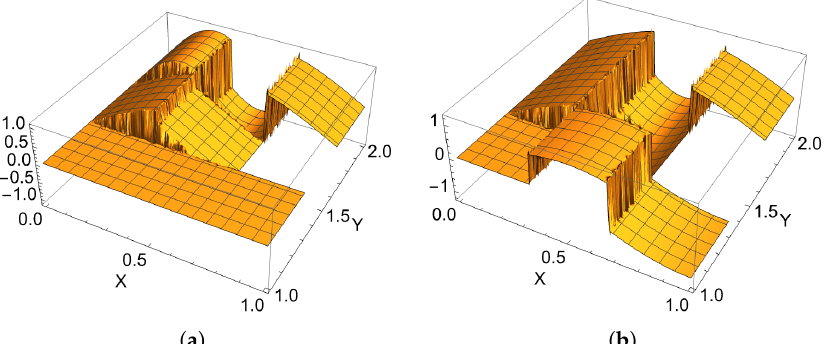
Figure 9. Eight regions. Realizations of the Young’s modulus in different configurations. The region with index 1 is set to zero for visualization purposes only. ( a ) Dimension index i = { 1,1,1,2,2,3,3,2 } , ( b ) Dimension index i = { 1,2,2,2,3,2,3,2 }